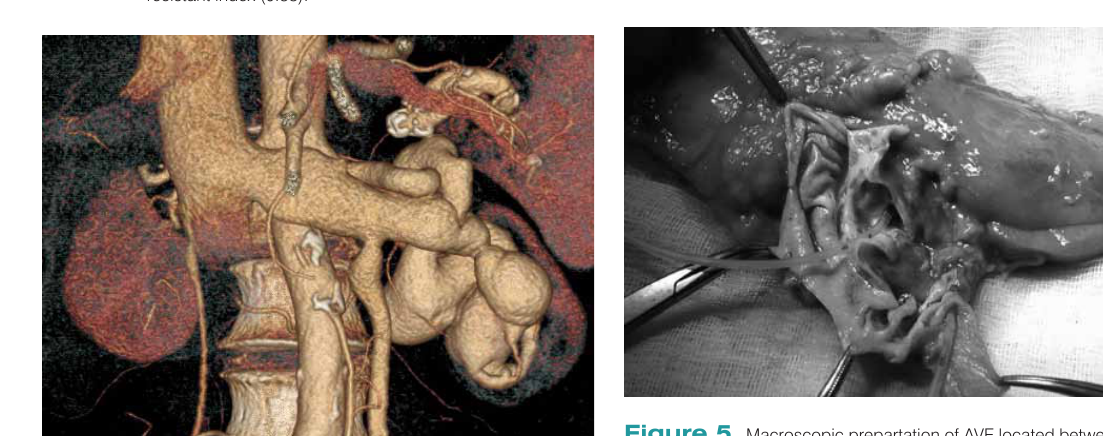
Figure 5. Macroscopic prepartation of AVF located between the main renal artery and vein. The catheter passes through the wide